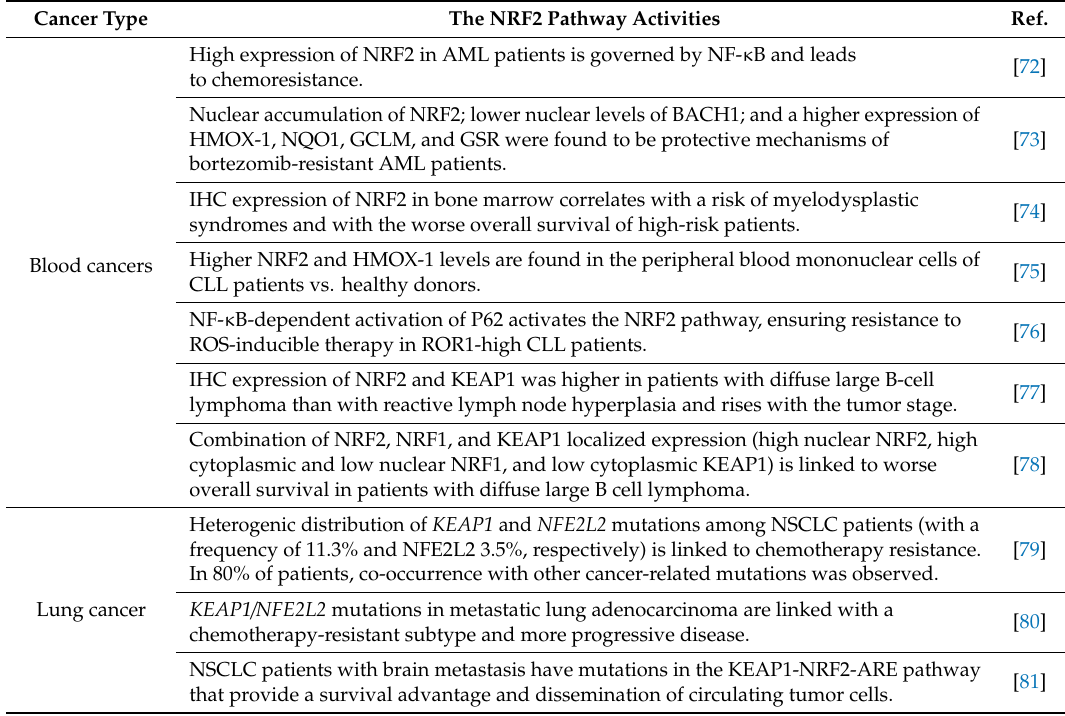
Table 1. The involvement of the NRF2 pathway in diverse types of